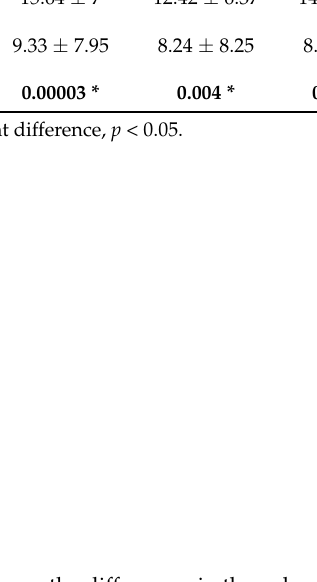
Figure 1. DPOAE Control versus migraine. The graph shows the differences in the value of DPOAE’ scores ( y -axis) between migraineurs and healthy subjects. ** indicates p < 0.0001.